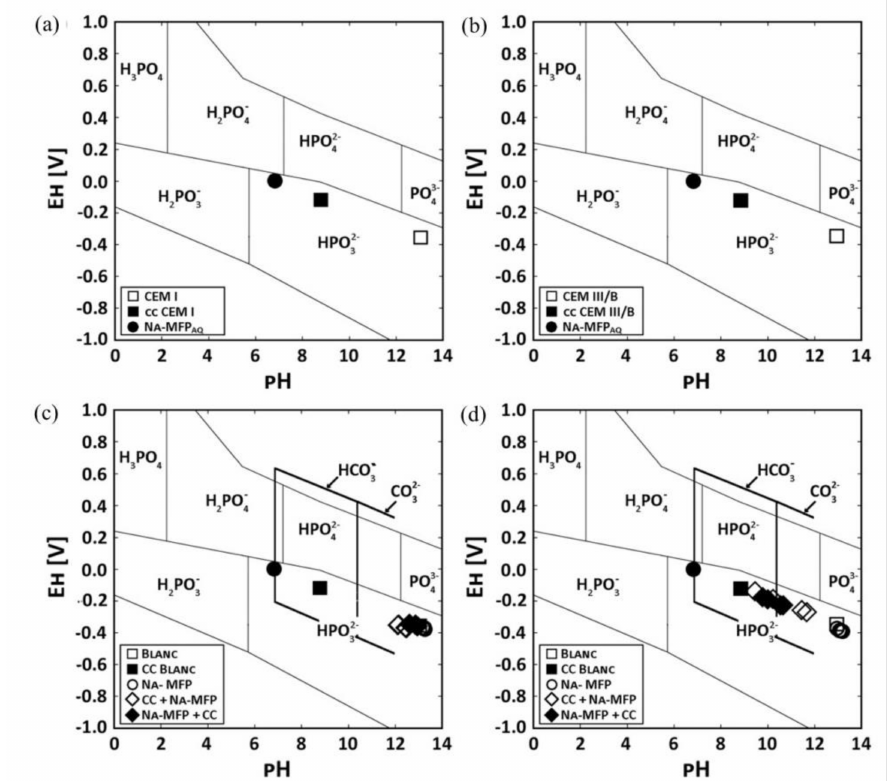
Figure 10. Pourbaix diagram of two different OPC cement pastes (CEM I and CEM III/B) showing the stability fields for phosphoric ions in solution and the E H − pH values of the pore solutions. pH values of the pore solutions from untreated CEM I, carbonated paste (cc) and the self-healing agent sodium monofluorophosphate (MFA) for: ( a ) CEM I and ( b ) CEM III/B, respectively. pH values of the pore solutions from paste samples that were either only impregnated with MFA or were first carbonated and impregnated with MFA (cc + MFA) or were impregnated with MFA and carbonated (MFA + cc) for: ( c ) CEM I and ( d ) CEM III/B, respectively. The thick black lines frame the stability of HCO 3 − and CO 32 − [72]. Reproduced with permission from Kempl, J. et al., Cem. Conc. Comp.; Published by Elsevier,